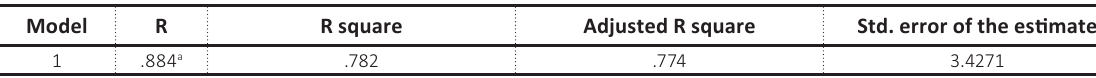
Table 4. Model summary